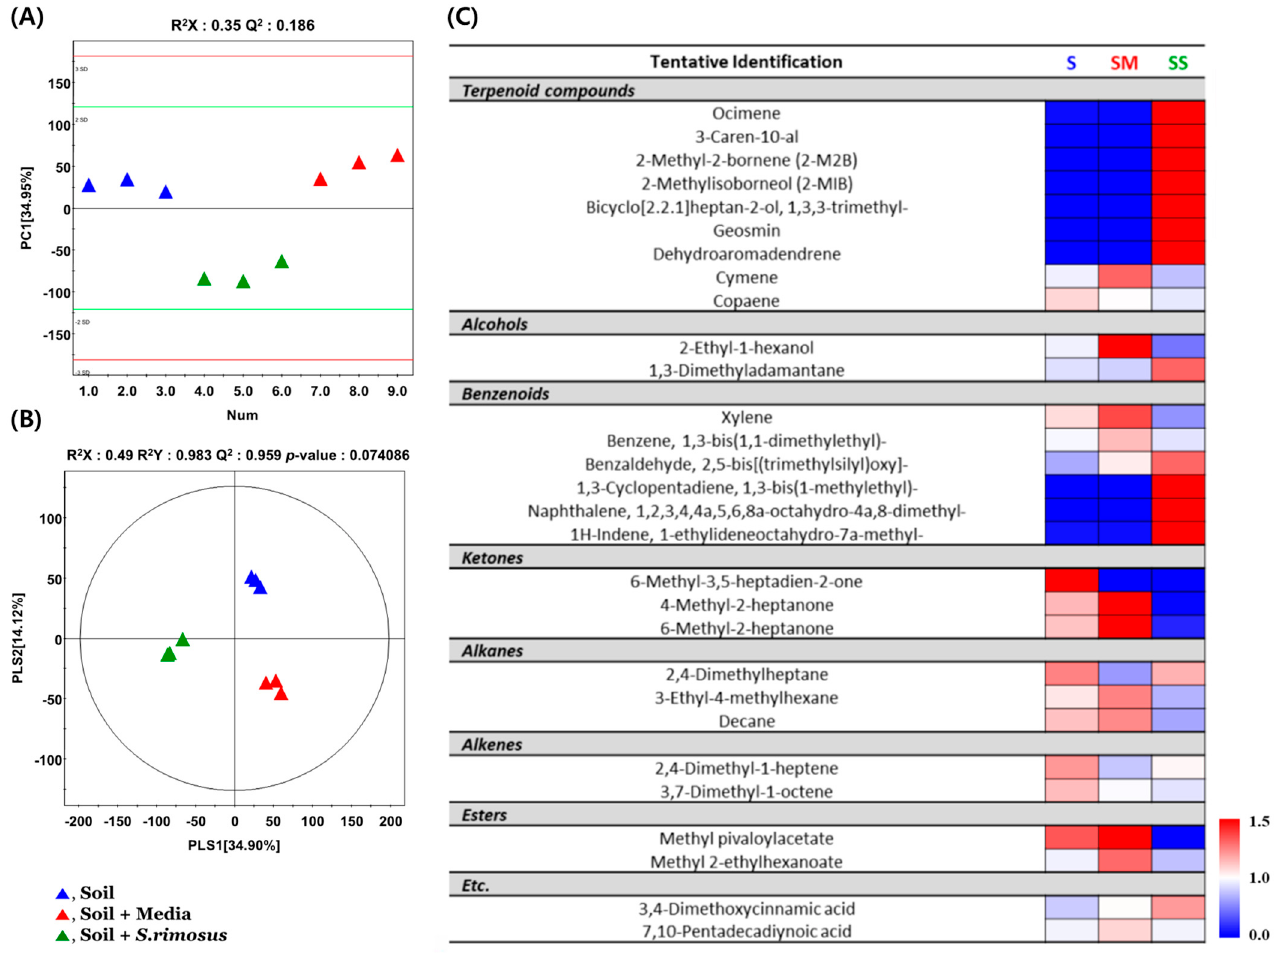
Figure 6. ( A ) Principal component analysis (PCA) and ( B ) partial least square discriminant analysis (PLS-DA) score plot derived from SPME–GC–TOF–MS datasets for various soil samples. Symbols: soil treated with distilled water (S, ▲ ); soil treated with culture media (SM, ▲ ); soil inoculated with S. rimosus ( SS , ▲ ). ( C ) Heat map analysis for the relative abundance of different volatile organic compounds (VOCs) (VIP > 0.7, p < 0.05) derived from the GC–TOF–MS analysis. The colored squares (blue to red) indicate fold changes that are normalized by the average of each metabolite.